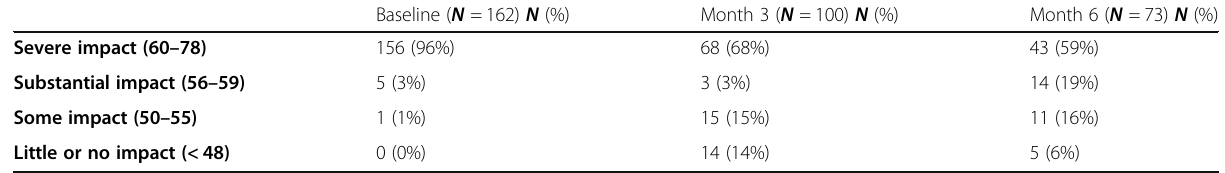
Table 3 Changes in HIT-6 headache disability categories after three and six erenumab treatments